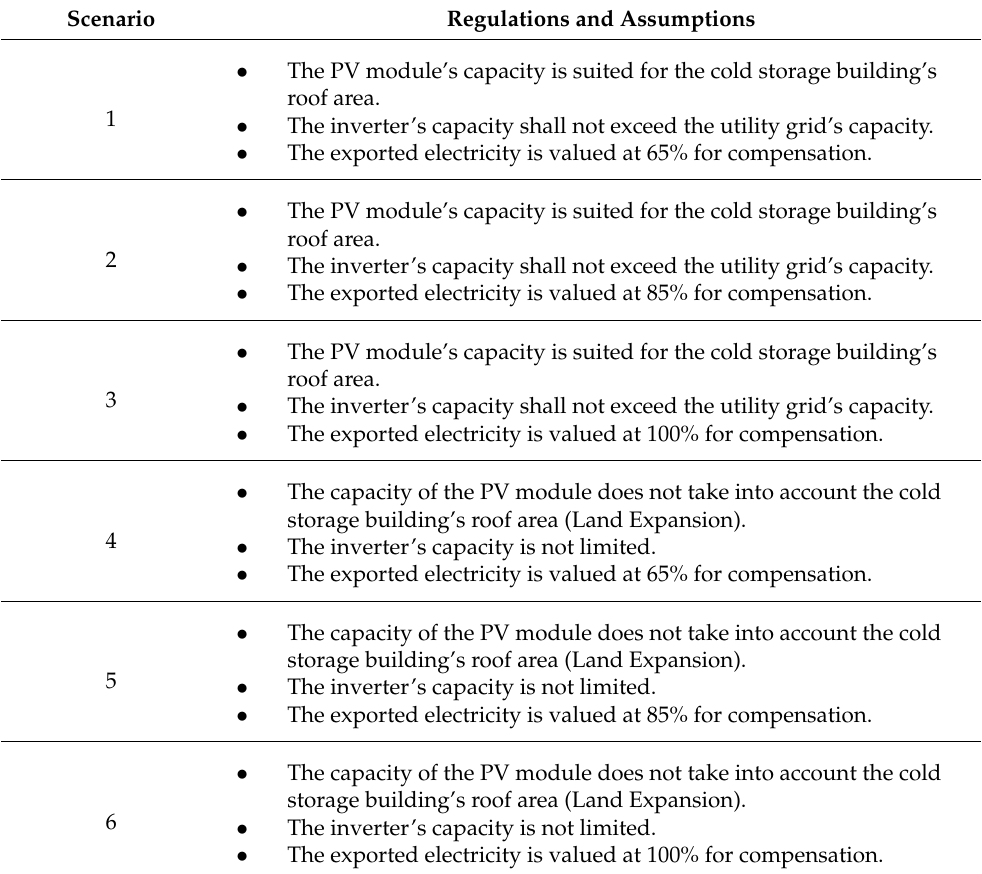
Figure 9. Process of techno-economic analysis with energy pricing and considered regulations. Table 3. Regulations and Assumptions for PV On-grid System